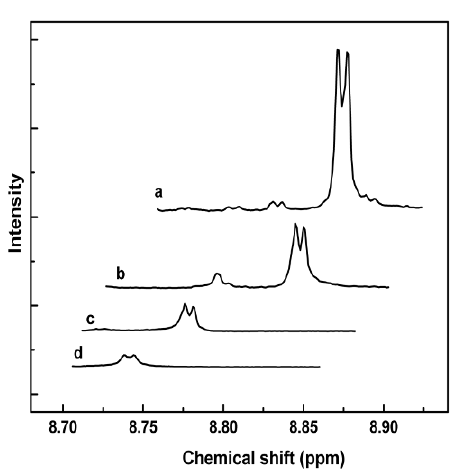
Figure 6. Expanded 1 H-NMR spectra for DNBE in mixtures with different PVK concentrations: (a) 0 M, (b) 0.077 M, (c) 0.232 M, and (d) 0.698 M.